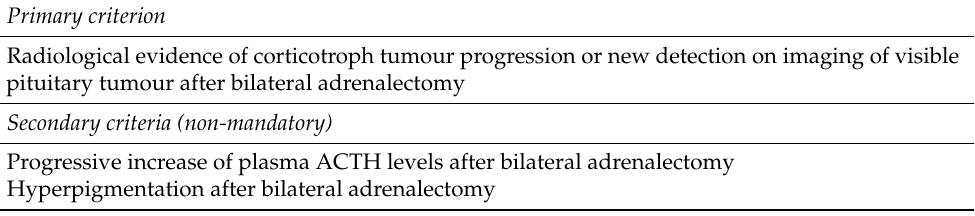
Table 1. Diagnostic criteria of Nelson’s syndrome